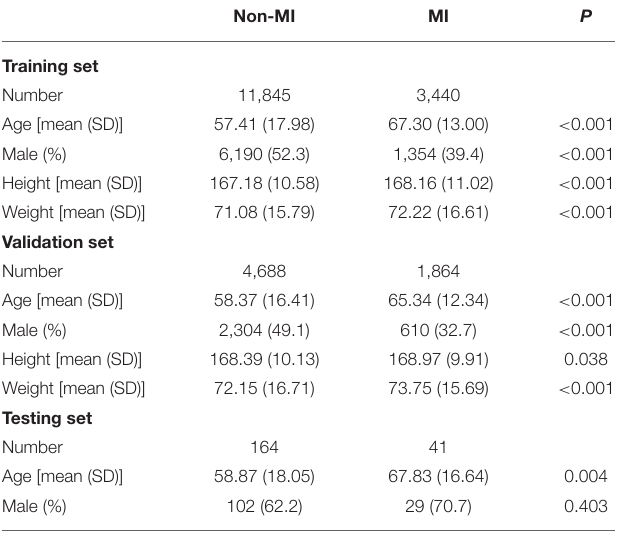
TABLE 1 | The baseline characteristics between patients with acute myocardial infarction ECGs and those with non-myocardial infarction ECGs. Non-MI